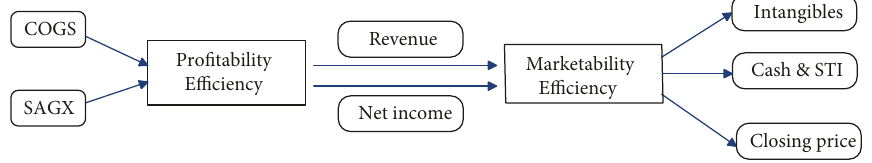
Figure 1: Research